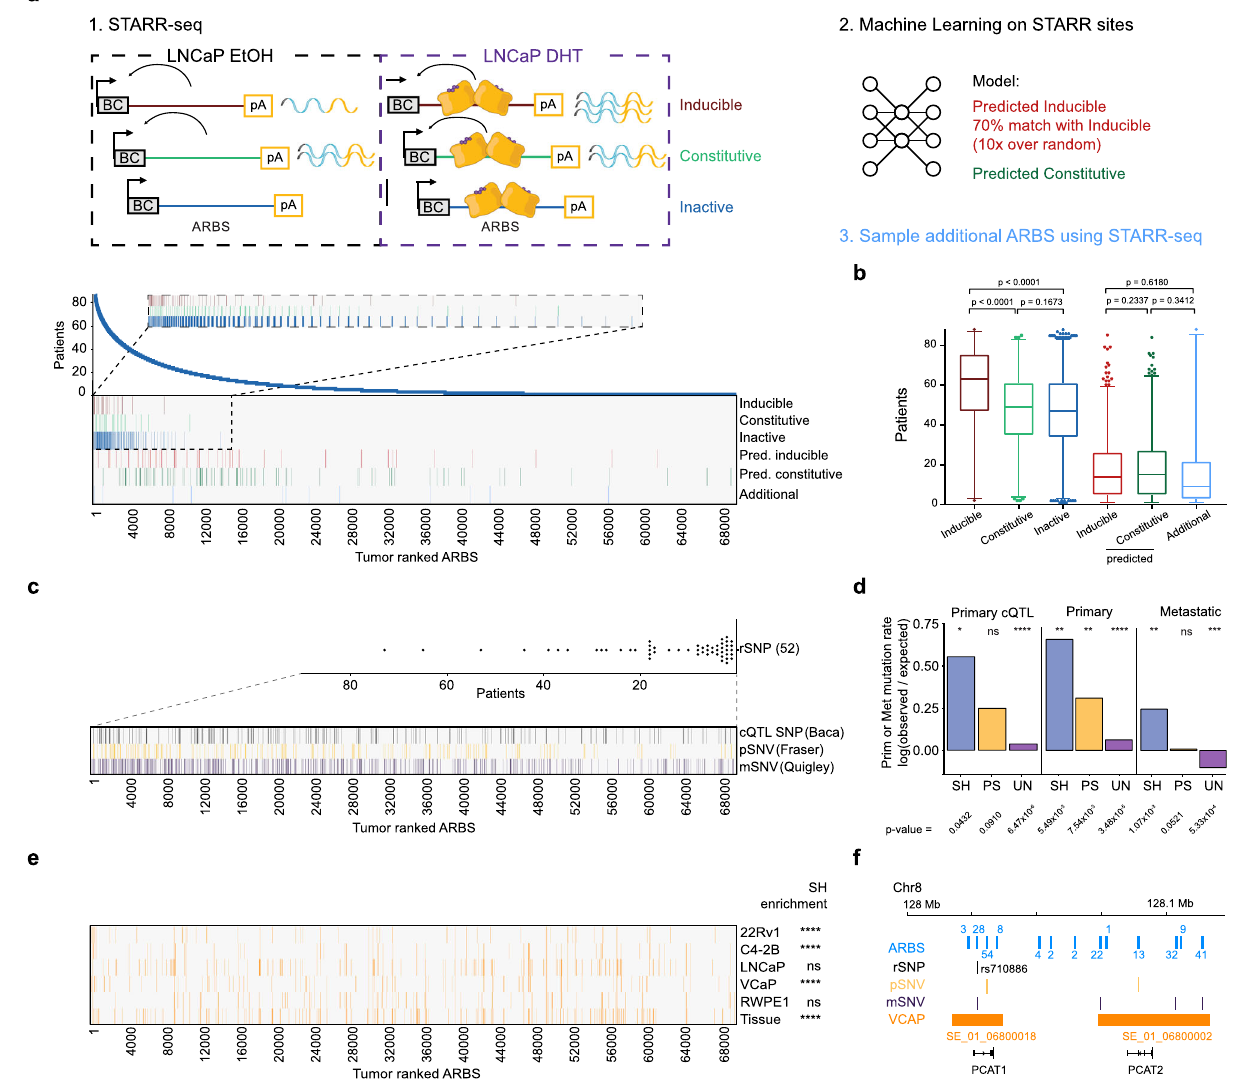
Fig. 2 | Ranked ARBS have functional divergence on AR enhancer activity, mutationalfrequency,andpresenceofsuperenhancersincelllinesandtissue. a Enhancer activity for ranked ARBS found in EtOH over DHT LNCaP conditions in STARR-seq, machine learning predicted ARBS, and the second set of designed ARBS. Inset: zoomed-in STARR-seq regions for ARBS ranked 1 – 15,000. b DistributionofARBSwithenhanceractivityidenti fi edinSTARR-seqexperiments. Inducible n =286, constitutive n =463, inactive n =2467, predicted inducible n =1237,predictedconstitutive n =1671,active n =149ARBS.Two-tailedStudent ’ s t - test of means. Centerline, median; upper and lower quartiles; whiskers, 1.5× inter- quartile range; points, outliers. c ARBS ranking with presence of PCa risk single nucleotide polymorphisms(rSNP,and singlenucleotide variations(SNV)identi fi